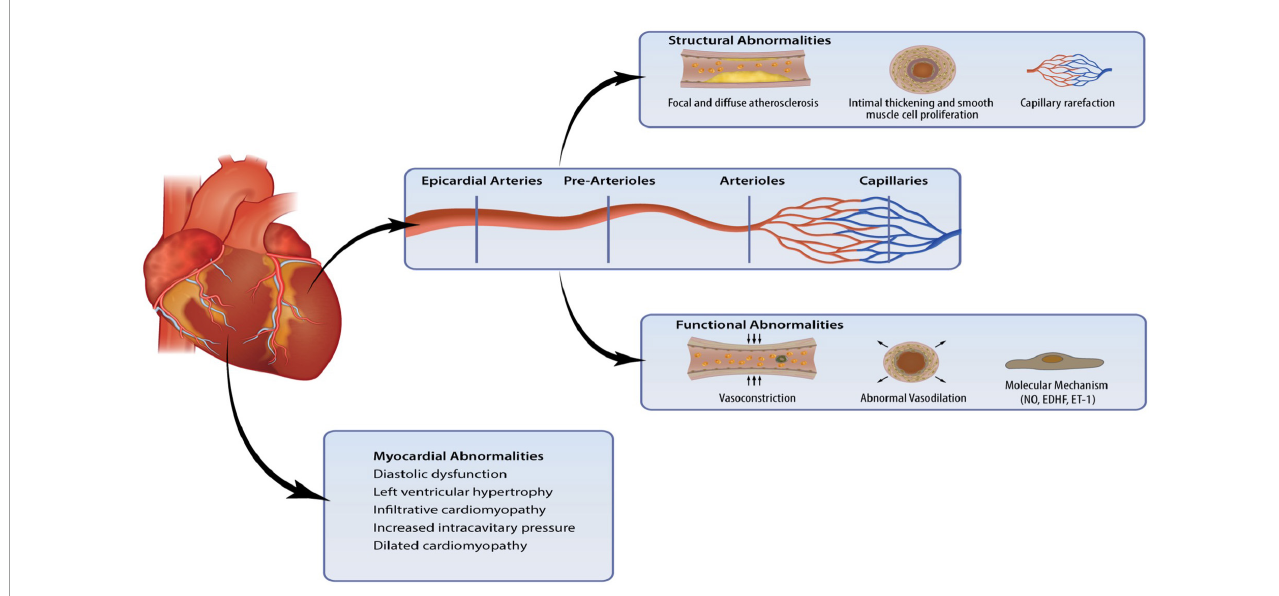
FIGURE1 Coronary microvascular dysfunction (CMD) is a result of pathogenic changes in the coronary microcirculation and myocardium. Structural and functional abnormalities lead to endothelial dysfunction and myocardial abnormalities can affect the intramural microvasculature.